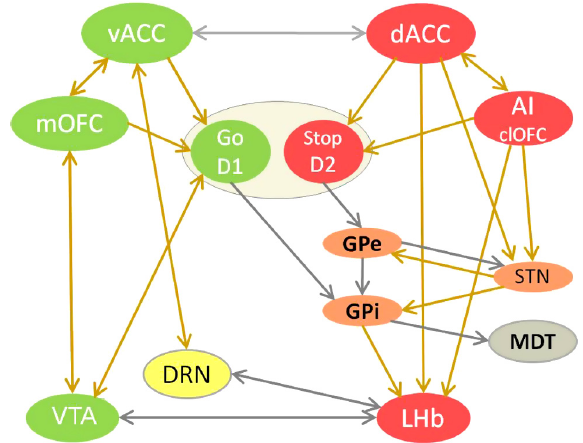
Figure 1. The competition between RPC and APC in choice beha-